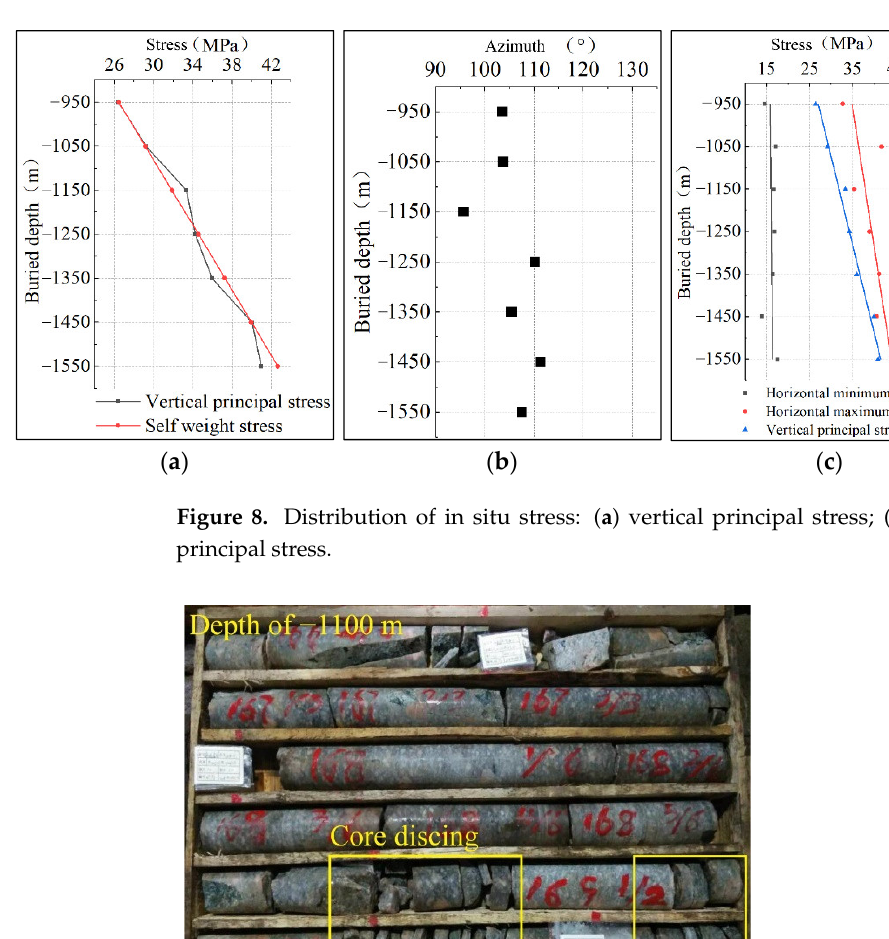
Figure 10. Stress relief process: ( a ) drilling and cleaning; ( b ) installing strain gauge probe; ( c ) stress relief and data acquisition; ( d ) obtaining core tube; ( e ) confining pressure calibration; ( f ) in situ stress calculation.